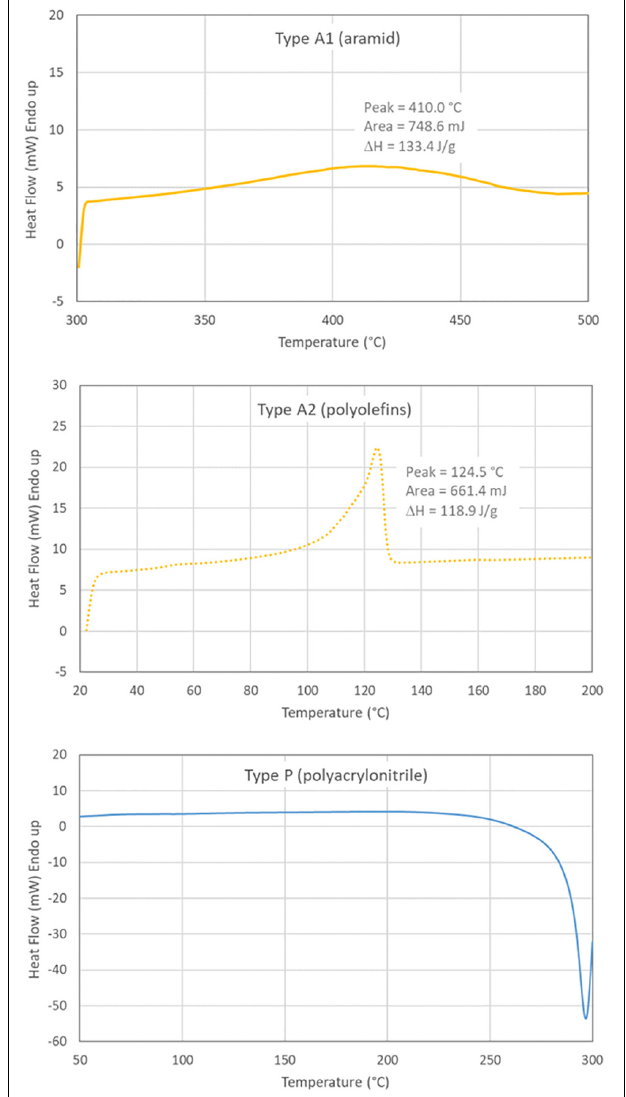
FIGURE 3 | Heat flow curves versus temperature for the different fibers studied. Aramid fiber (top) , polyolefins fiber (medium) and polyacrylonitrile fiber (bottom)